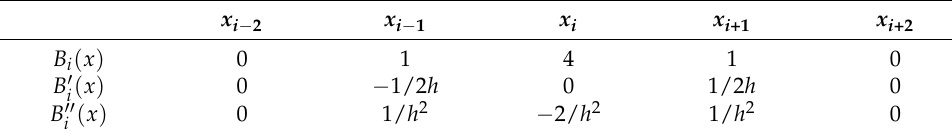
( x ) at the ( x ) and B (cid:48)(cid:48) i i